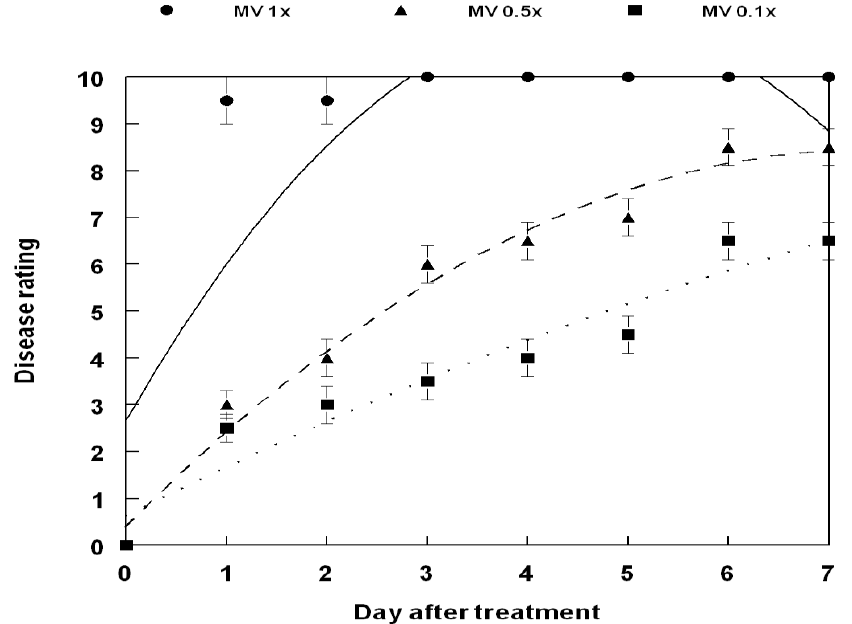
Figure 4. Disease progression on 10–20 cm tall hemp sesbania in rice field plots incited by a Myrothecium verrucaria mycelial formulation. Disease severity was based on a visual rating scale (per plant basis) [50] to estimate disease progression. A rating scale of 0 to 10 was used, as described in the Materials and Methods section. Symptomatology was considered ―severe‖ at ratings of 8–10. The relationships for M. verrucaria disease progression are best described by the equations: Y = 1.10 + 3.05 X − 0.28 X 2 , R 2 = 0.92 (solid spheres, solid line) for M. verrucaria applied at an inoculum rate of 1.0×; Y = 0.44 + 2.16 − 0.15 X 2 , R 2 = 0.98 (solid triangles, dashed line) for M. verrucaria applied at an inoculum rate of 0.5×; Y = 0.67 + 1.06 − 0.04 X 2 , R 2 = 0.94 (solid squares, dotted line) for M. verrucaria applied at an inoculum rate of 0.1×. Error bars = ±1 SEM.